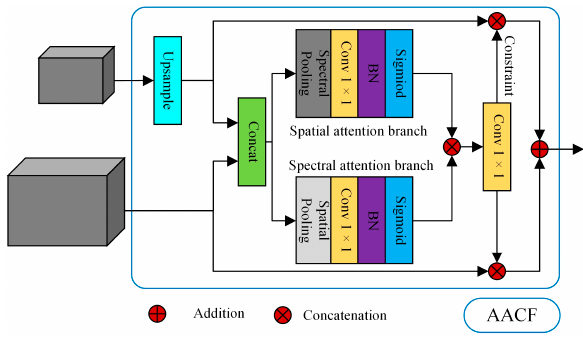
Figure 4. Adaptive attention fusion module.